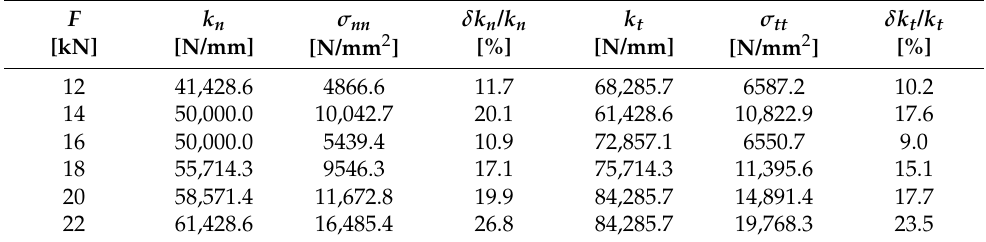
Table 1. Obtained results of search for k n and k t